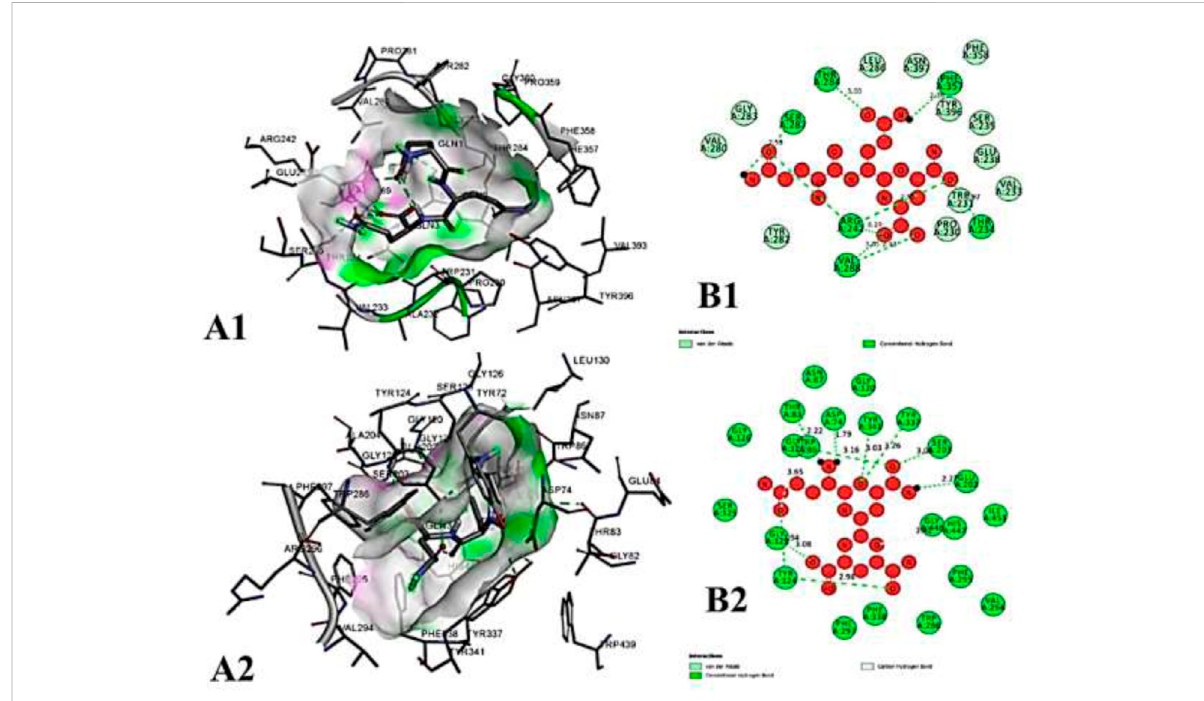
FIGURE 8 The molecular docking interactions of ligand dehydronimodipine with (A) 4AQD and (B) 4EY7 receptors in 2D and 3D representation.